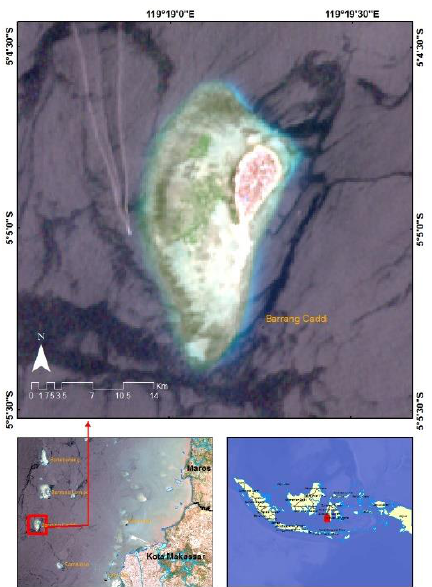
Figure 1. Research location, Badi Island, Spermonde Islands,